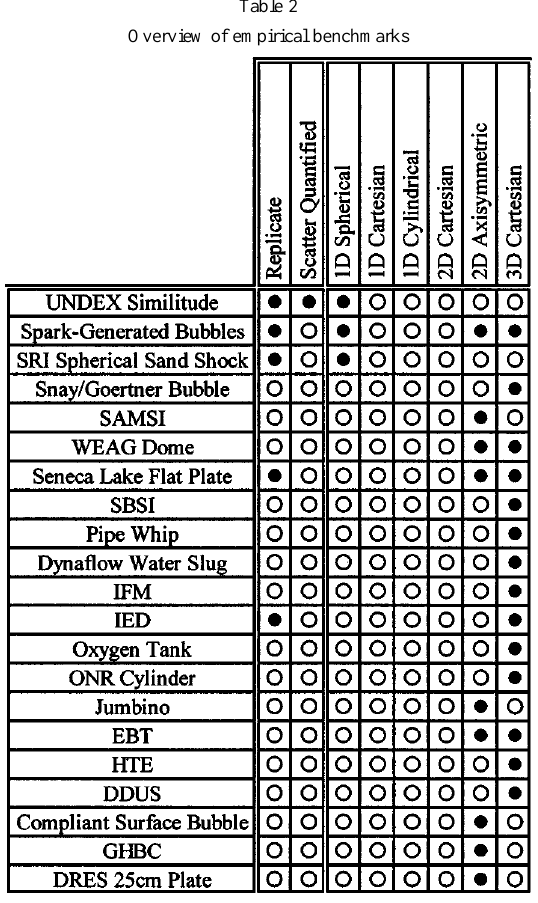
Overview of analytical benchmarks Overview of empirical